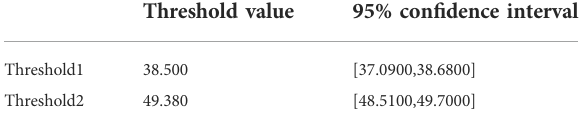
TABLE 10 Threshold estimation